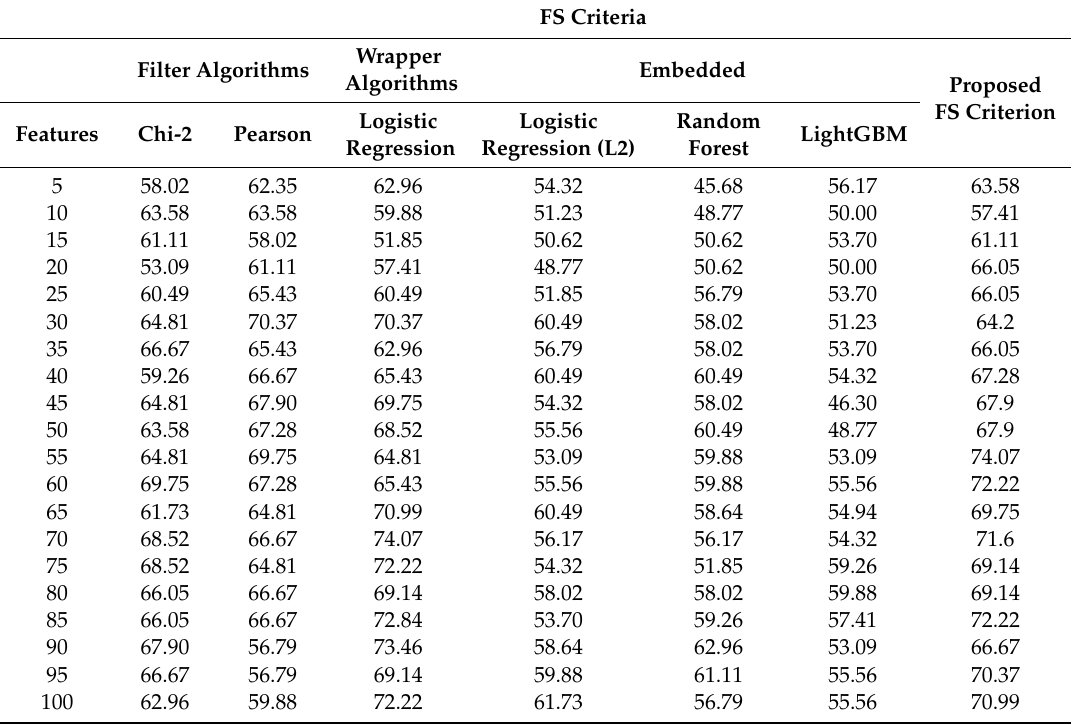
Table 10. Testing performance (%) of the competing FS techniques with respect to the number of selected features for dataset D.